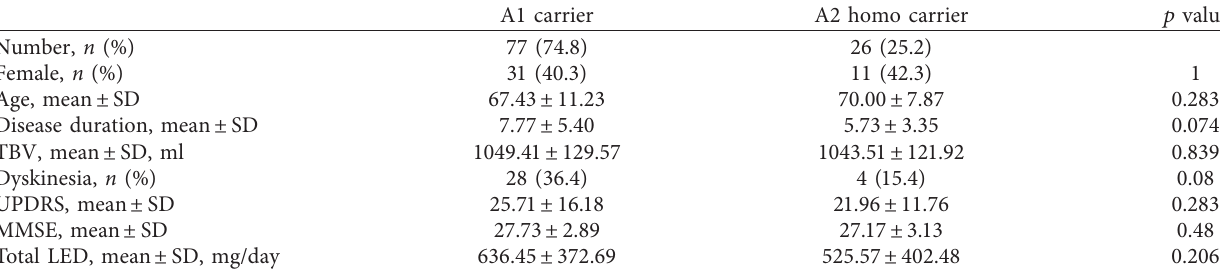
Table 2: Demographic and clinical characteristics of PD patients.